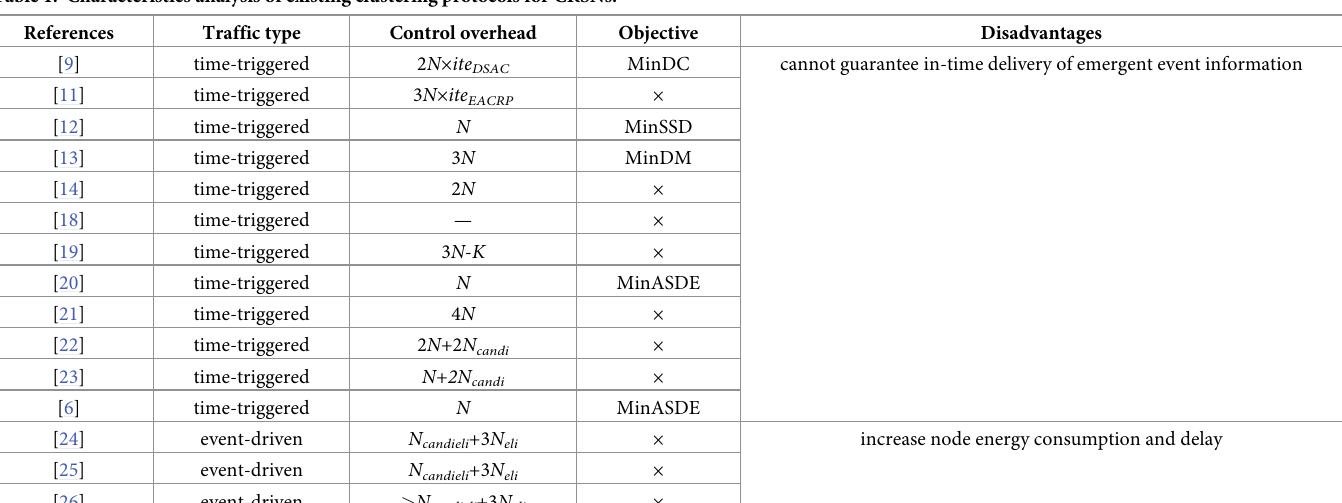
Table 1. Characteristics analysis of existing clustering protocols for